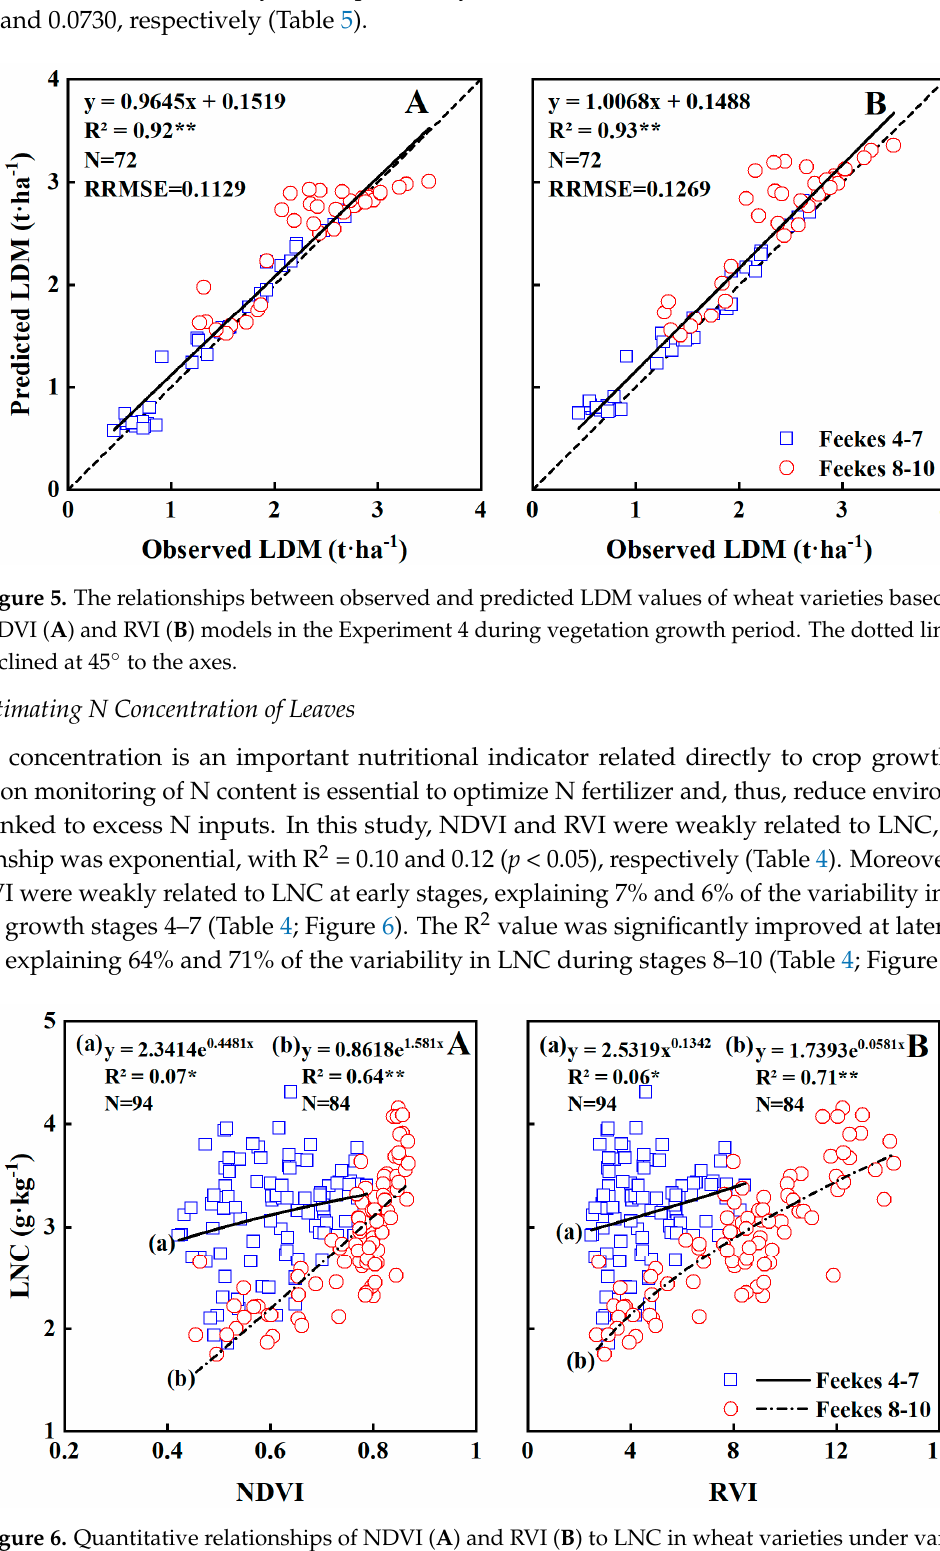
Figure 4. Quantitative relationships of NDVI ( A ) and RVI ( B ) to LDM in wheat varieties under varied N rates across all growth stages.